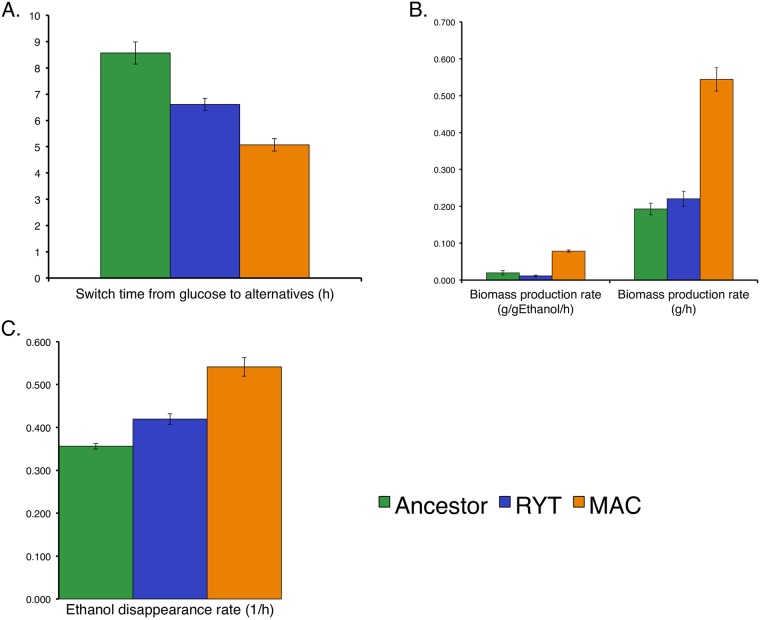
Post-diauxic condition comparative physiology of yeasts.(A) MAC (orange) swiftly switched from glucose to alternative carbon source in a significantly shorter time as compared to ancestor (green) and RYT (blue) strains (t-test, p < 0.01). (B) MAC demonstrated higher biomass production (t-test, p < 0.01) and (C) consumed ethanol faster than all strains (t-test, p < 0.01). MAC is associated with a fitter phenotype in post-diauxic phase based on these parameters.